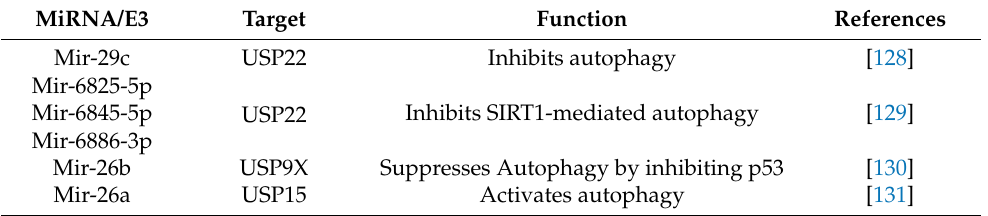
Table 2. MiRNAs and DUBs involved in autophagy.